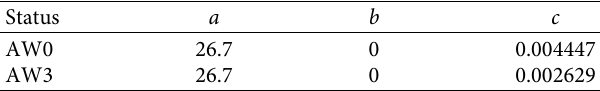
Table 3: Coefficients of the formula concerning resistance per unit of metro train.